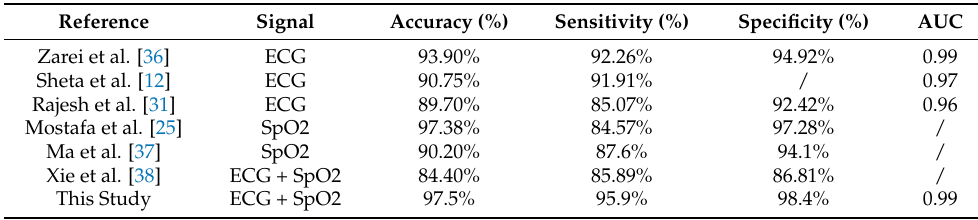
Table 6. Comparison of the proposed method with other previous